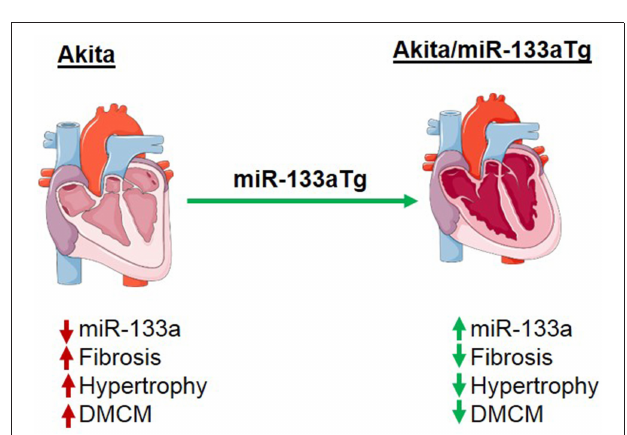
FIGURE 8 | Schematic presentation showing the effect of miR-133a on prevention of cardiac fibrosis and cardiomyopathy in the diabetic heart. In the diabetic Akita heart, cardiac miR-133a is downregulated but cardiac fibrosis, hypertrophy, and diabetic cardiomyopathy (DMCM) were increased. However, transgenic expression of miR-133a in the diabetic Akita heart increases the levels of miR-133a and consequently decreases cardiac fibrosis, hypertrophy, and